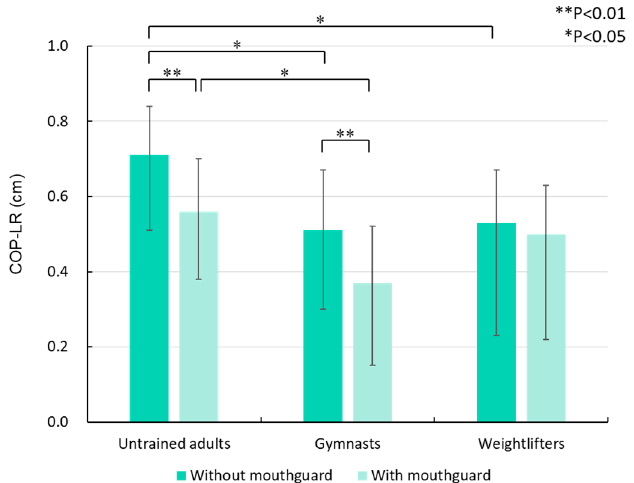
Figure 5. Comparison of center of pressure displacement in the left-and-right direction (COP-LR) among participant groups by mouthguard condition. Measurements are expressed as means ± SD. error bar indicates standard error of the mean. ** p < 0.01, * p < 0.05: denotes statistically significant difference.